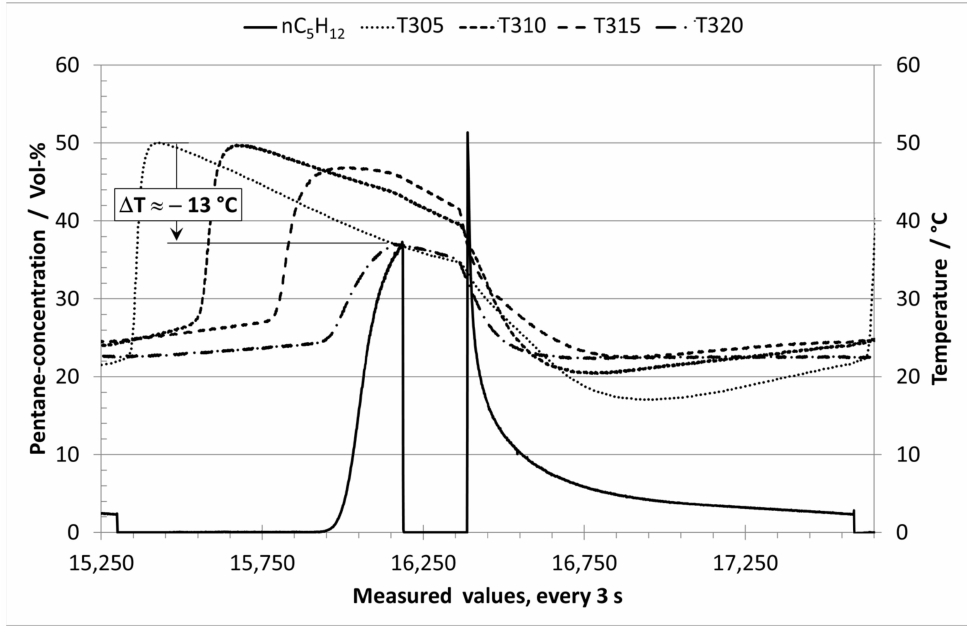
Figure 5. Concentration and temperature profile in the filter for E0/humid N 2 in 250th